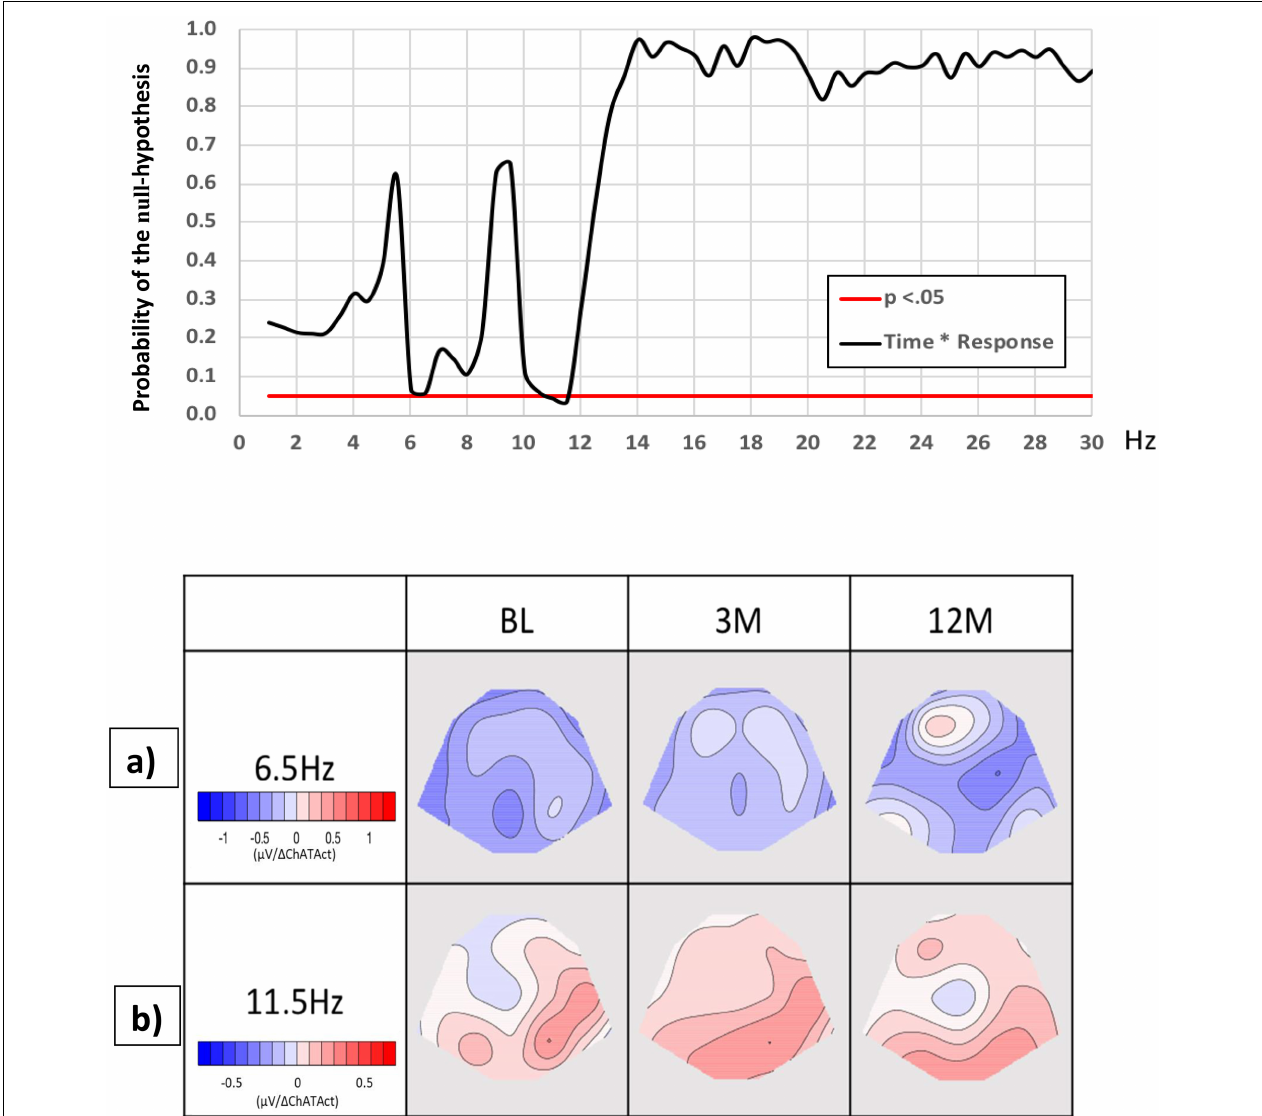
FIGURE 3 | Associations between CSF ChAT activity and EEG spectral power as a function of time during the NGF delivery. The graph shows the probability (p) of the null hypothesis ( y -axis) for the TANCOVA interaction between time and change in CSF ChAT activity, as a function of EEG frequency in Hz. The significant ( p < 0.05) frequency range is marked by a white line. The red cursor marks the frequency range represented by the covariance maps. Maps display topographic covariance of the EEG spectral power correlating to changes in ChAT activity at the frequency ranges: (a) 6.0–6.5 for the three EEG recording occasions. The blue maps show where lower than the average difference in CSF ChAT values correlated with an increase in the theta frequency, (b) 11.0–11.5 Hz for the three EEG recording occasions. The red maps indicate where a higher than average difference in CSF ChAT activity (12 months vs. baseline) is related to an increase in upper alpha frequency. BL, baseline; ChAT, choline acetyltransferase; CSF, cerebrospinal fluid; EEG, electroencephalography; TANCOVA, topographic analysis of covariance, 3 m: 3 months, 12 m: 12